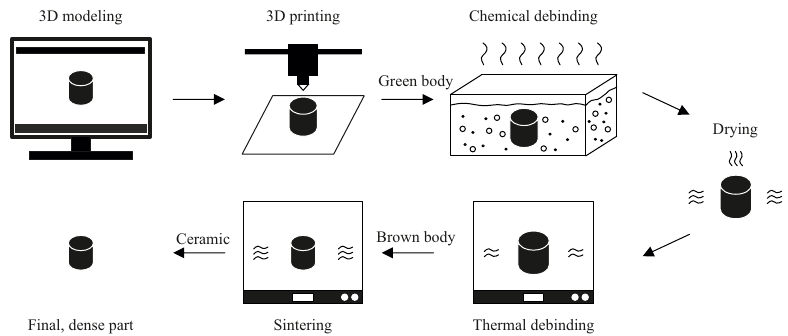
Figure 1. Schematic representation of 3D printing ceramics and post-processes.